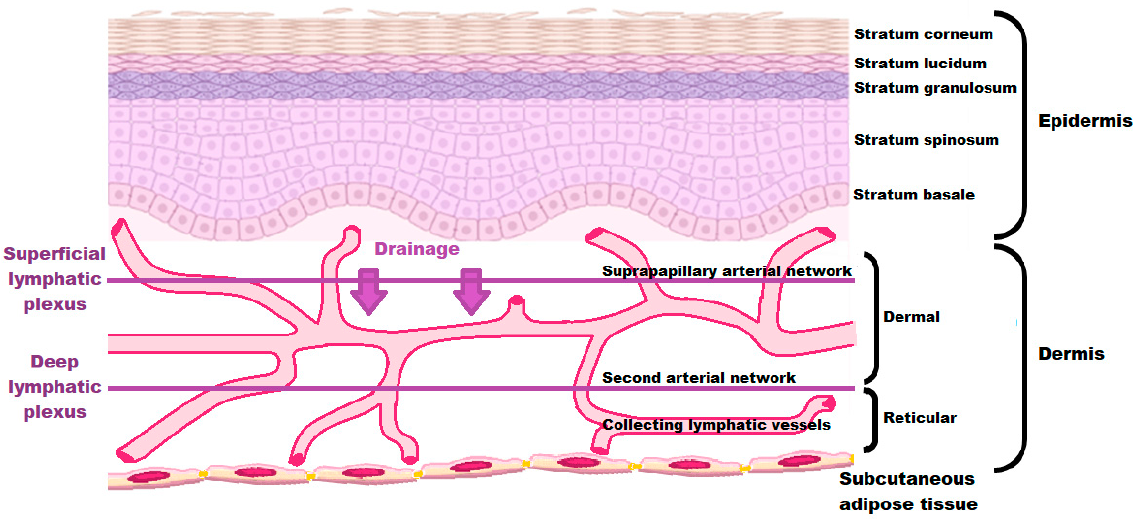
Figure 3 . Structure of the lymphatic network of the skin . Figure 3. Structure of the lymphatic network of the